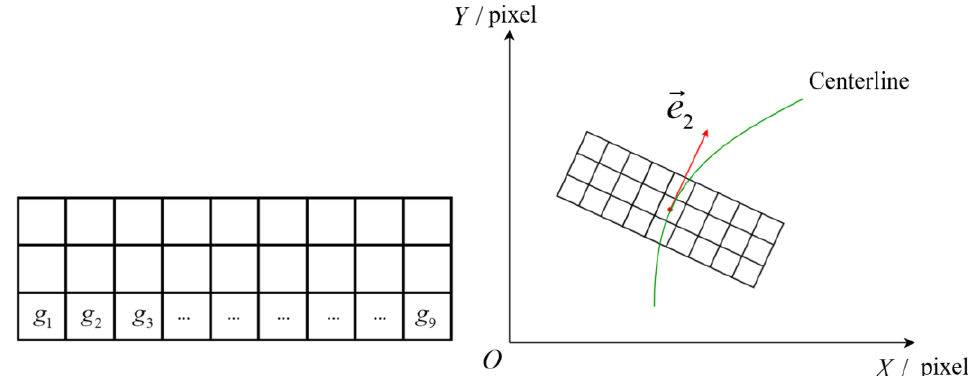
Figure 4. Structure of the sliding window.